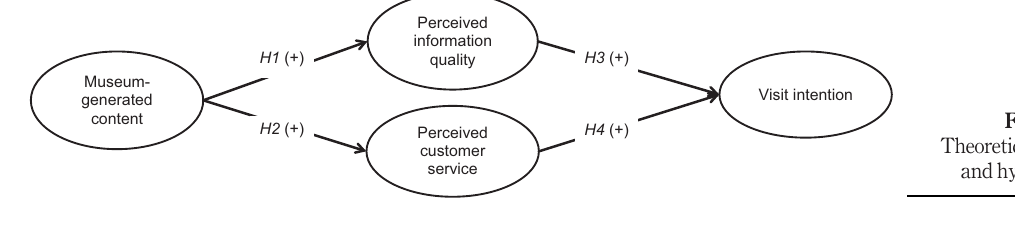
Figure 1. Theoretical